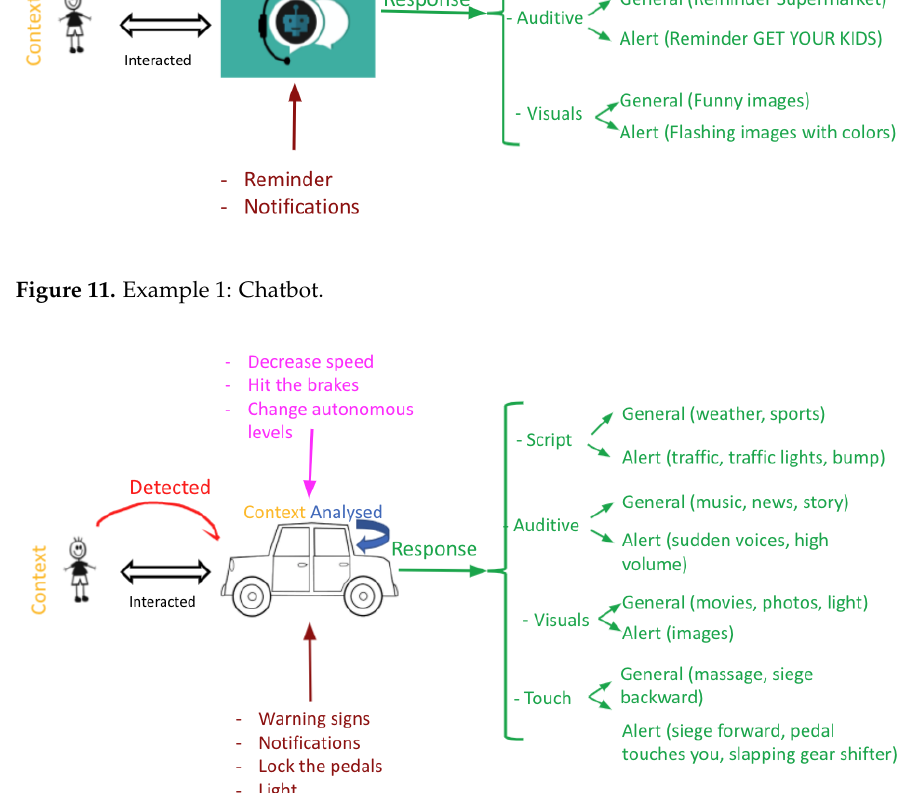
Figure 12. Example 2: Autonomous